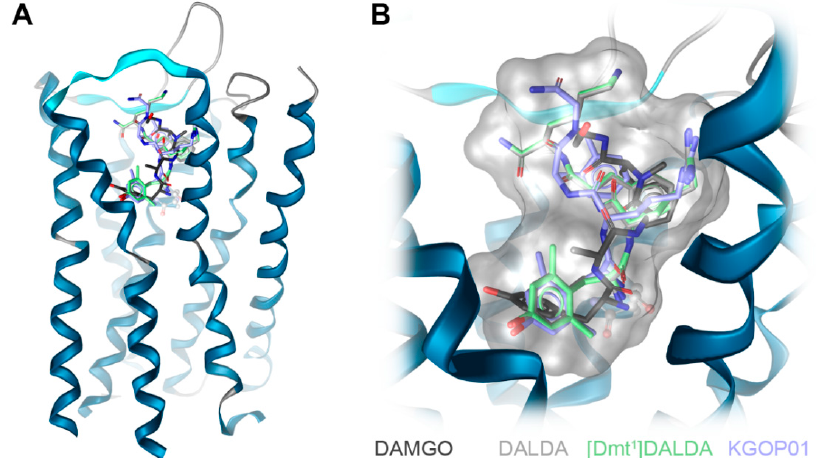
Figure 4. Superimposition of the crystal structure of the MOR (PDB ID: 5C1M) with co-crystallized BU72 (grey), and the recently available cryo-EM structure (PDB ID: 6DDF) with bound DAMGO (blue) in a transmembrane ( A ) and extracellular view ( B ). The close-up view on DAMGO (blue surface) in the binding site ( C ) unveils a sterical clash (circle) of the peptide with the N-terminus resolved in the active crystal structure.